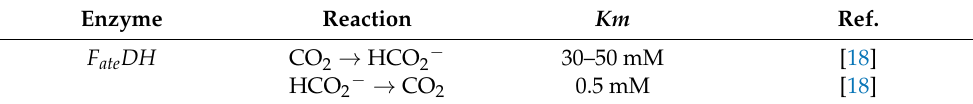
Table 1. Km values for the CO 2 reduction–formate oxidation reactions.